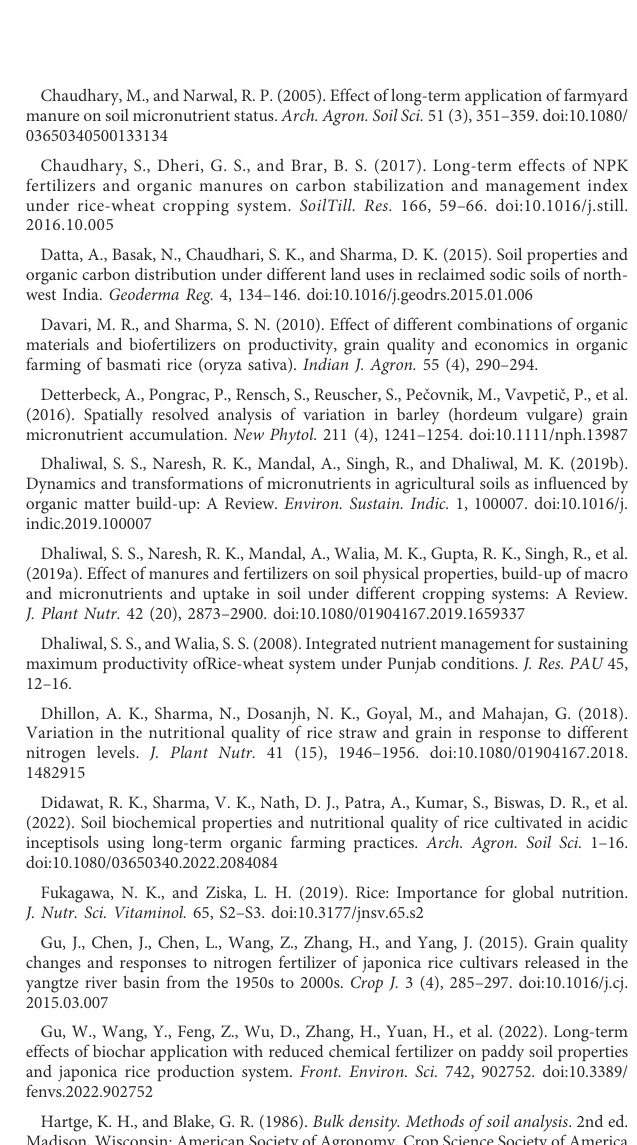
SUPPLEMENTARY TABLE S1 Cropping history of the experimental fi eld from 2001-2021. SUPPLEMENTARY TABLE S2 Experimental design and treatments details. SUPPLEMENTARY TABLE S3 Layout of experimental